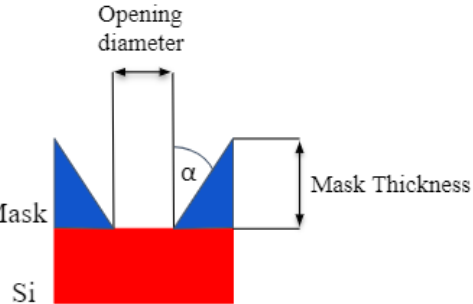
Figure 6. Illustration of the taper angle α . For the impact of the mask tapering angle, small angles on relatively thick masks are considered. In mask faceting, ion bombardment sputters away the top mask corner and results in an effective taper angle as well. However, the angles tend to be larger and the impact is analyzed for thin masks.